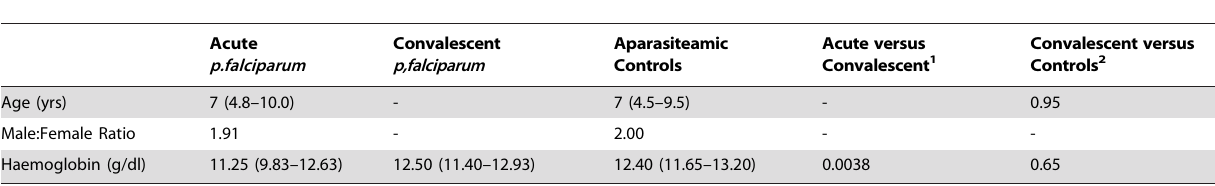
Table 1. Age, sex and haemoglobin levels of uncomplicated P.falciparum cases and aparasitaemic controls.